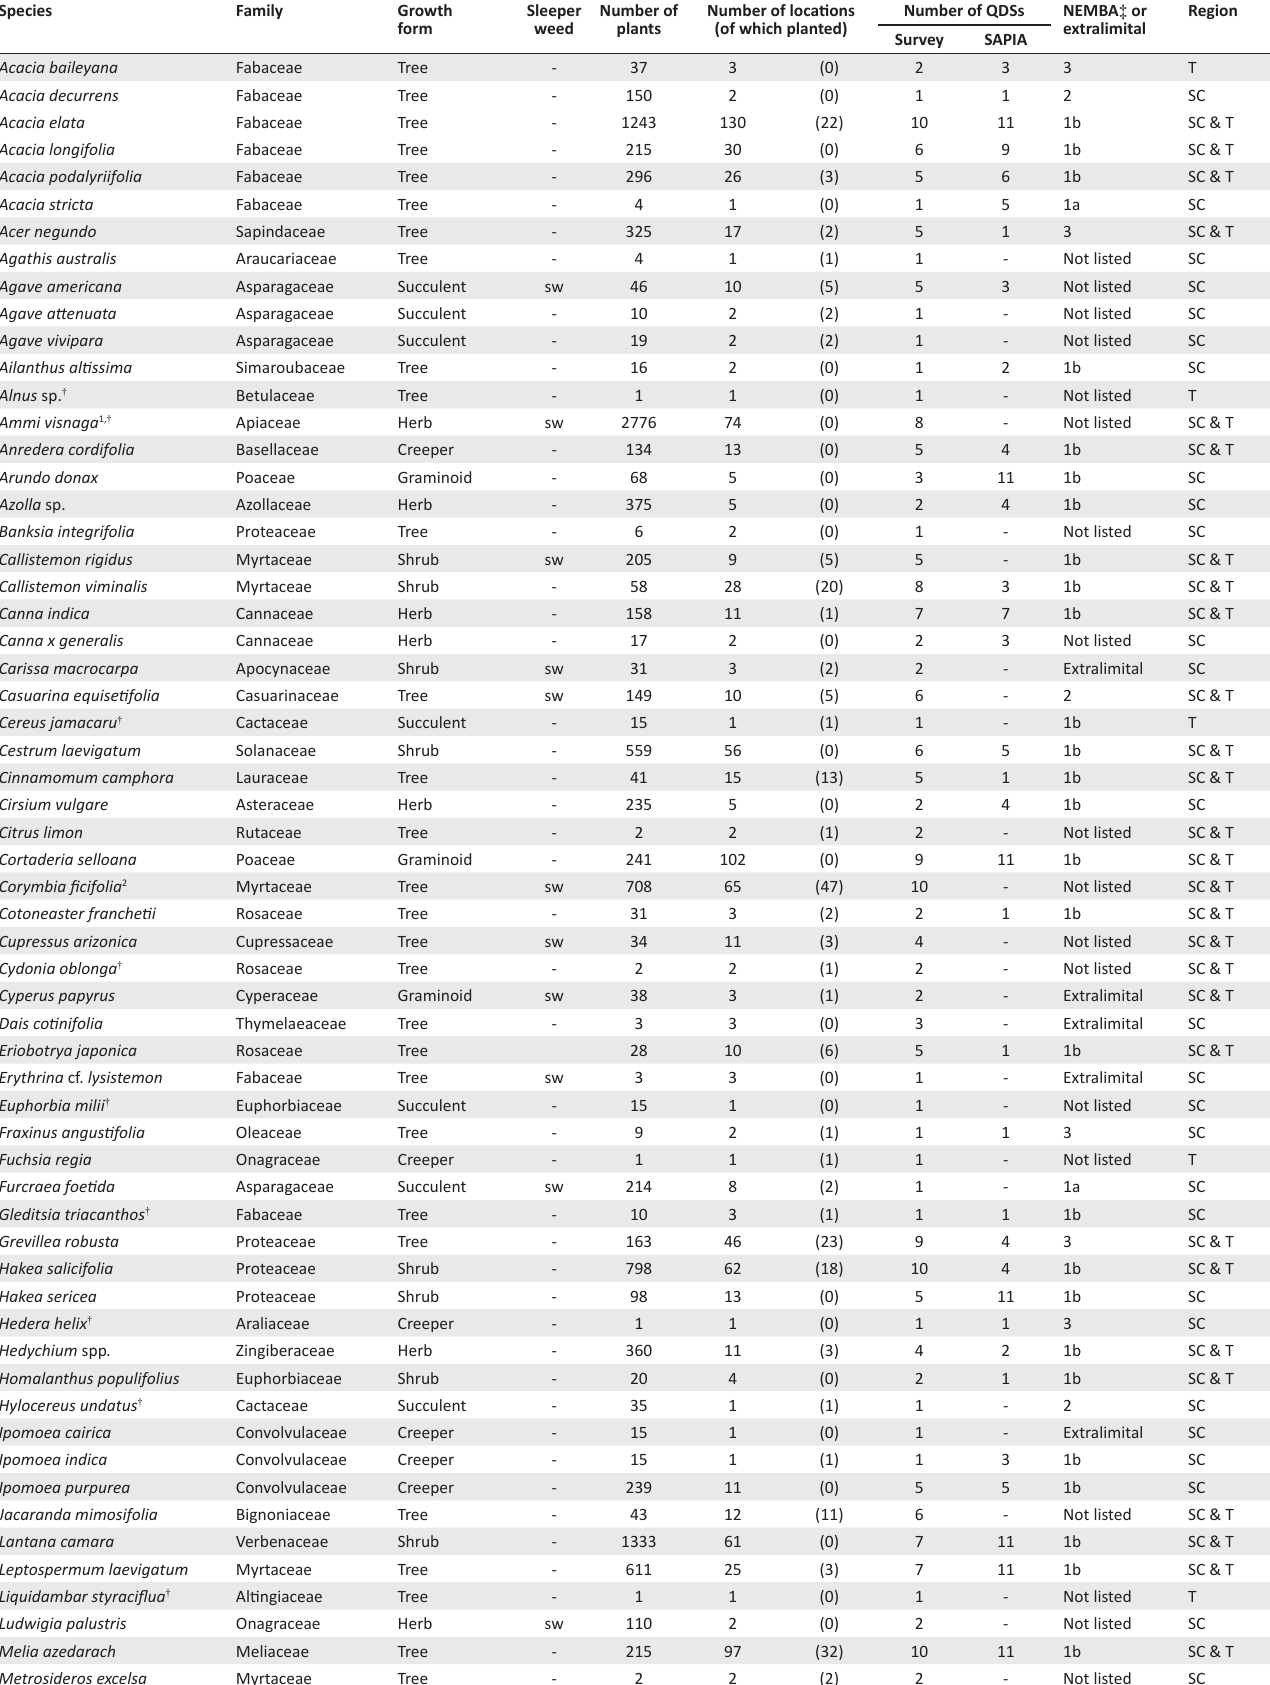
TABLE 1: Alien and extralimital plant species recorded in the roadside survey and associated information.